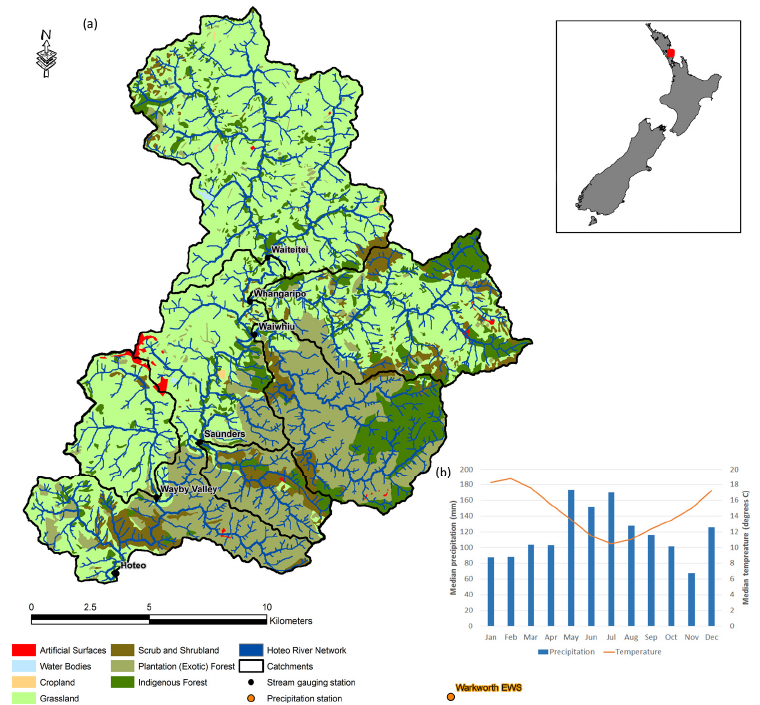
Figure 1. ( a ) The Hoteo catchment (located on the North Island, NZ) and its five sub-catchments (black lines) delineated based on the location of gaging stations. Land cover (LCDB v3.3) is shown for reference. Precipitation data were drawn from Warkworth EWS climate station, located 8 km south-east of Hoteo; ( b ) Climograph created from data drawn from Warkworth EWS climate station for the period 2000–2013. Table 1. Summary of landscape and water quality data used for this